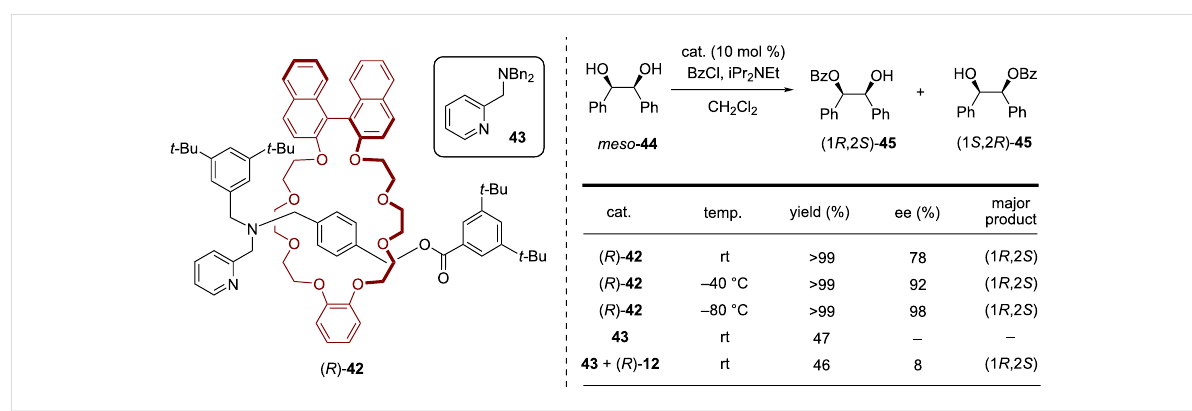
Figure 11: The asymmetric desymmetrization reaction of meso -1,2-diols with rotaxane ( R )- 42